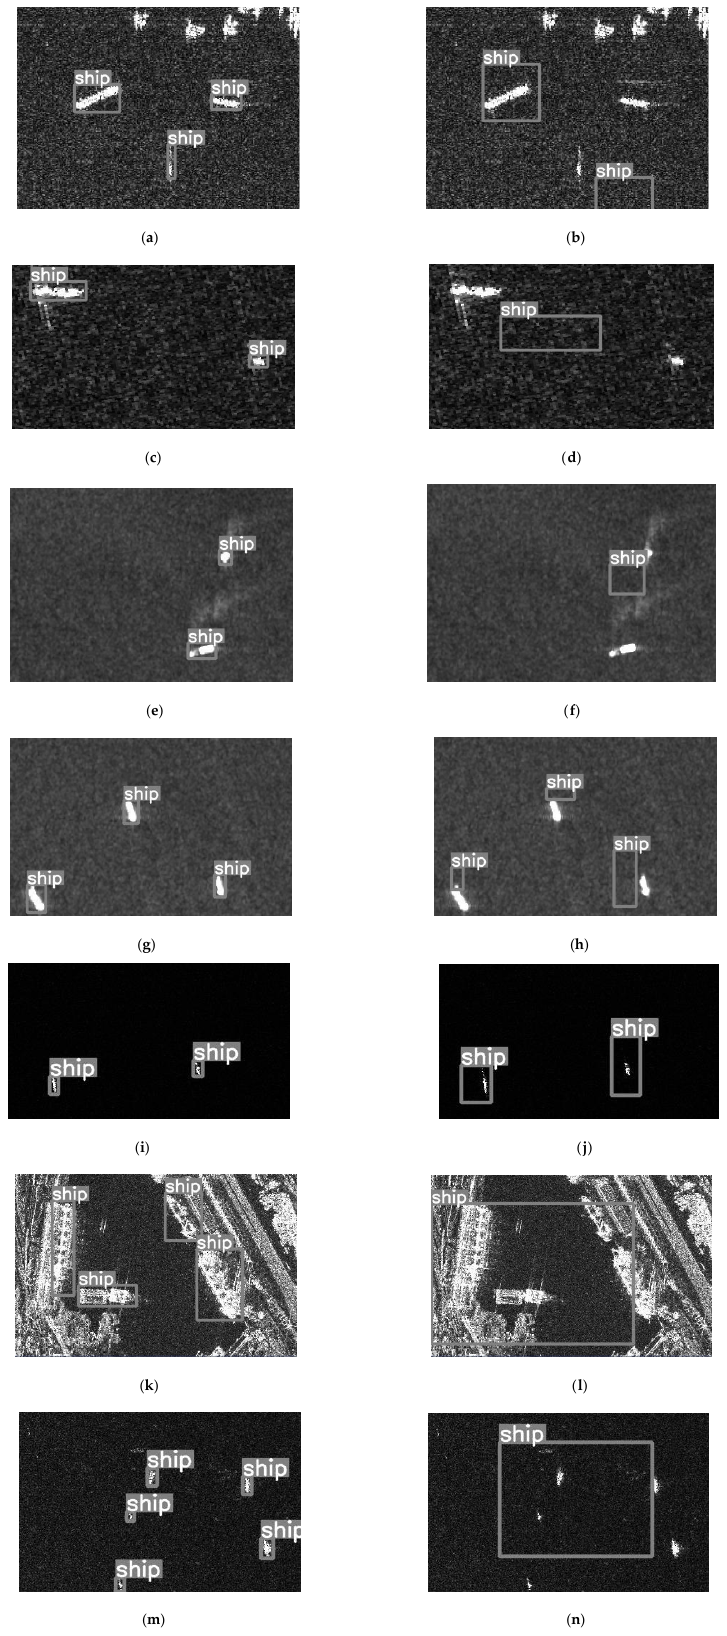
Figure 2. Comparison of the detection effect before and after the attack (The ( a , c , e , g , i , k , m ) panels show the detection effects of the models before the attacks. The ( b , d , f , h , j , l , n ) panels show the de- tection effects of the models after the attacks.).